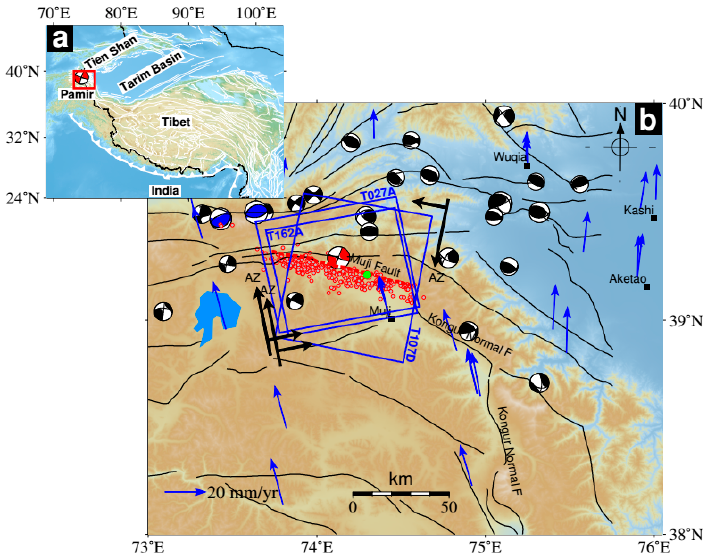
Figure 1. Topographic and tectonic map surrounding the 2016 Mw 6.6 Aketao earthquake, western China. ( a ) Location map showing the relative positions of Pamir, Tibet and India plate. The red rectangular box outlines the study area. White lines indicate the regional faults. ( b ) Location of the Aketao earthquake in Pamir. The red beach ball represents the focal mechanism of the 2016 Aketao earthquake, the black beach balls are the Mw ≥ 5.0 historical earthquakes from 1976 to 2016 around Pamir. The blue beach balls, from west to east, denote the focal mechanisms of the 2016 Kyrgyzstan M 6.4 earthquake and the 2008 Wuqia Mw 6.7 earthquake, respectively. All the focal mechanisms were obtained from the global CMT webpage [4]. The small red circles indicate the relocated aftershocks within five days after the main shock, the solid green circle denotes the M 5 aftershock [1]. The black lines delineate the major active faults on Pamir, the seismogenic fault is marked by the red line. Blue boxes outline the spatial coverage of the Sentinel-1A SAR images (ascending track T027), Sentinel-1B SAR images (descending track T107) and ALOS-2 L-band SAR images (ascending track T162). Blue vectors are the interseismic GPS velocities relative to the Eurasian reference frame [6].